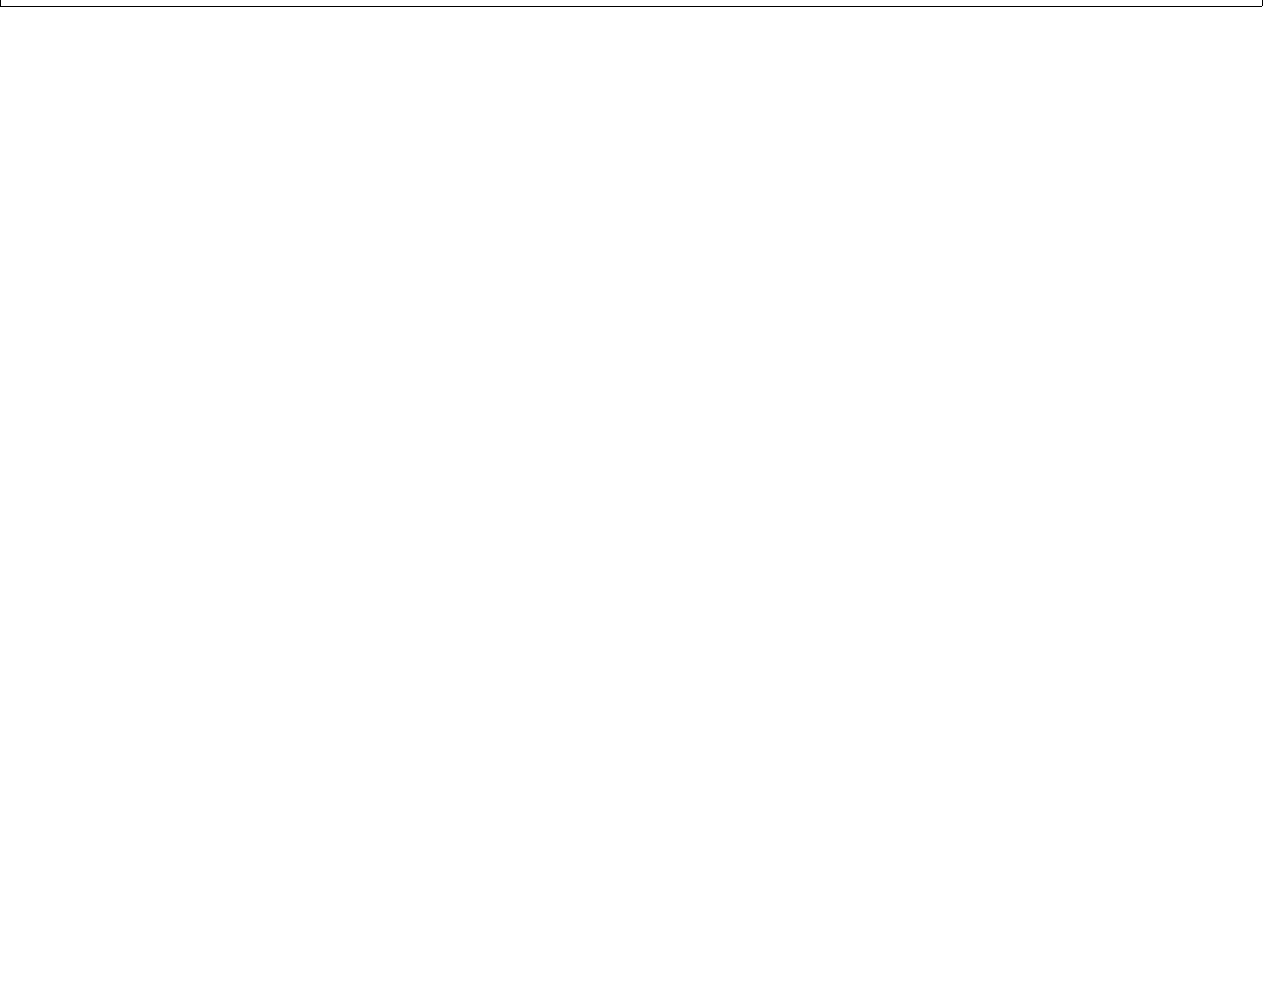
FIGUREA2 | Comparison of the ChR2-evoked network with the sensory-evoked network. (A) A weighted, directed network diagram was derived following photostimulation of each ROI in the unilateral preparation by using the unilateral connectivity matrix ( n = 6 mice) shown in Figure 4D . Nodes were placed according to the site of photostimulation with size proportional to the strength of connections per node (sum of weights). Arrow thickness is related to weight of an individual connection. Only output from